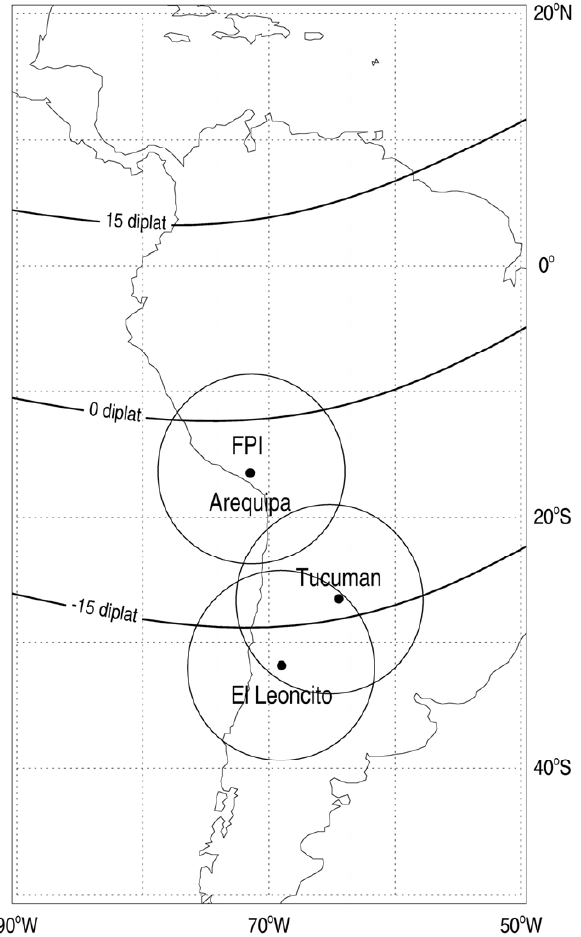
Fig. 1. The geographic locations of three Southern Hemisphere all- Figure 1. sky imaging systems used in this study. The circles represent 75 ◦ of the fields of view at 300km with the dots representing the zeniths of the imagers. The location of a FPI is also indicated at Arequipa’s